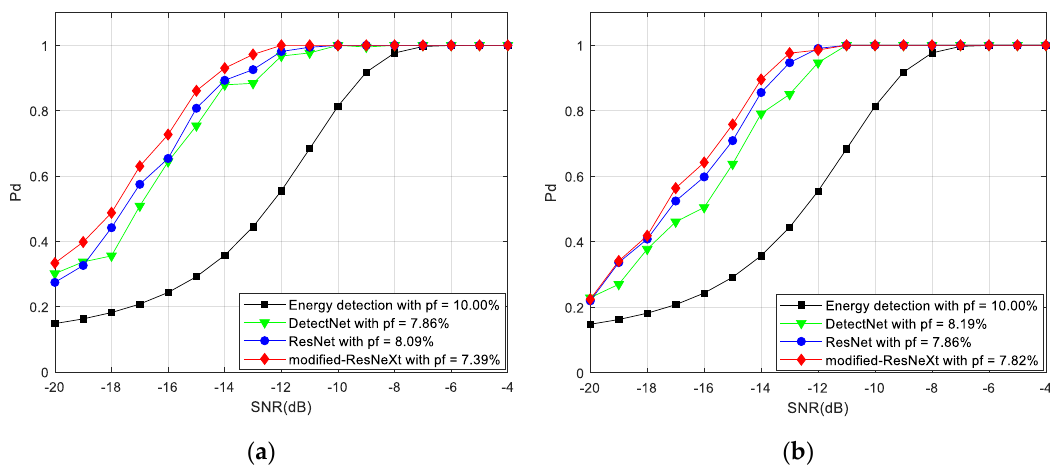
Figure 2. Detection performance of various algorithms. ( a ) Detection performance under urban environment; ( b ) Detection performance under highway environment.